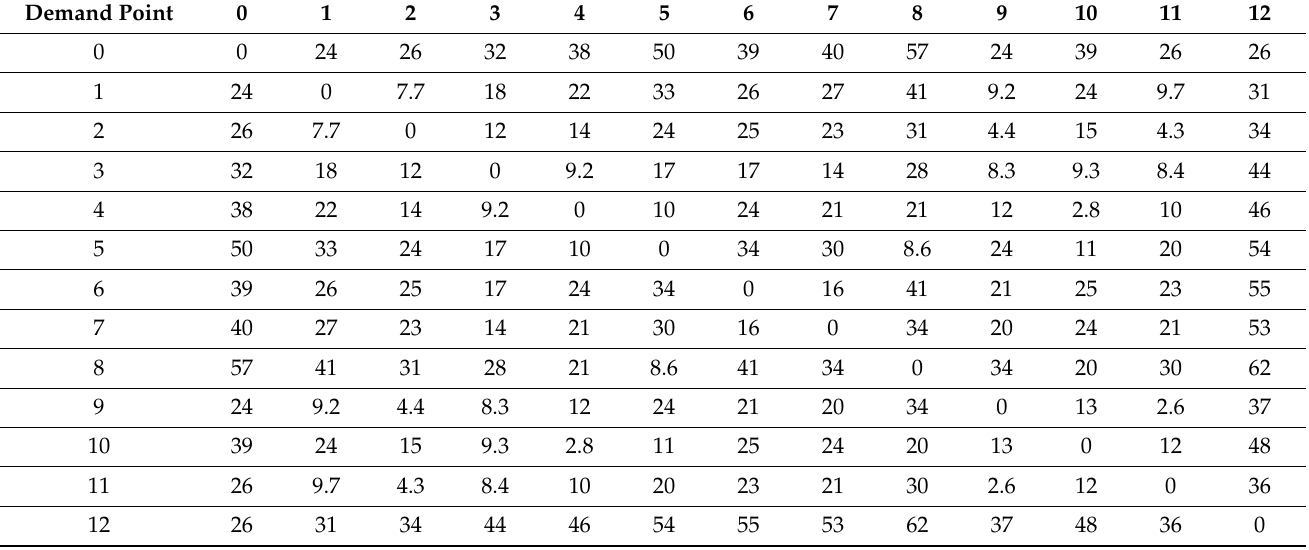
Table 11. The shortest distance between the distribution center and the sentinel